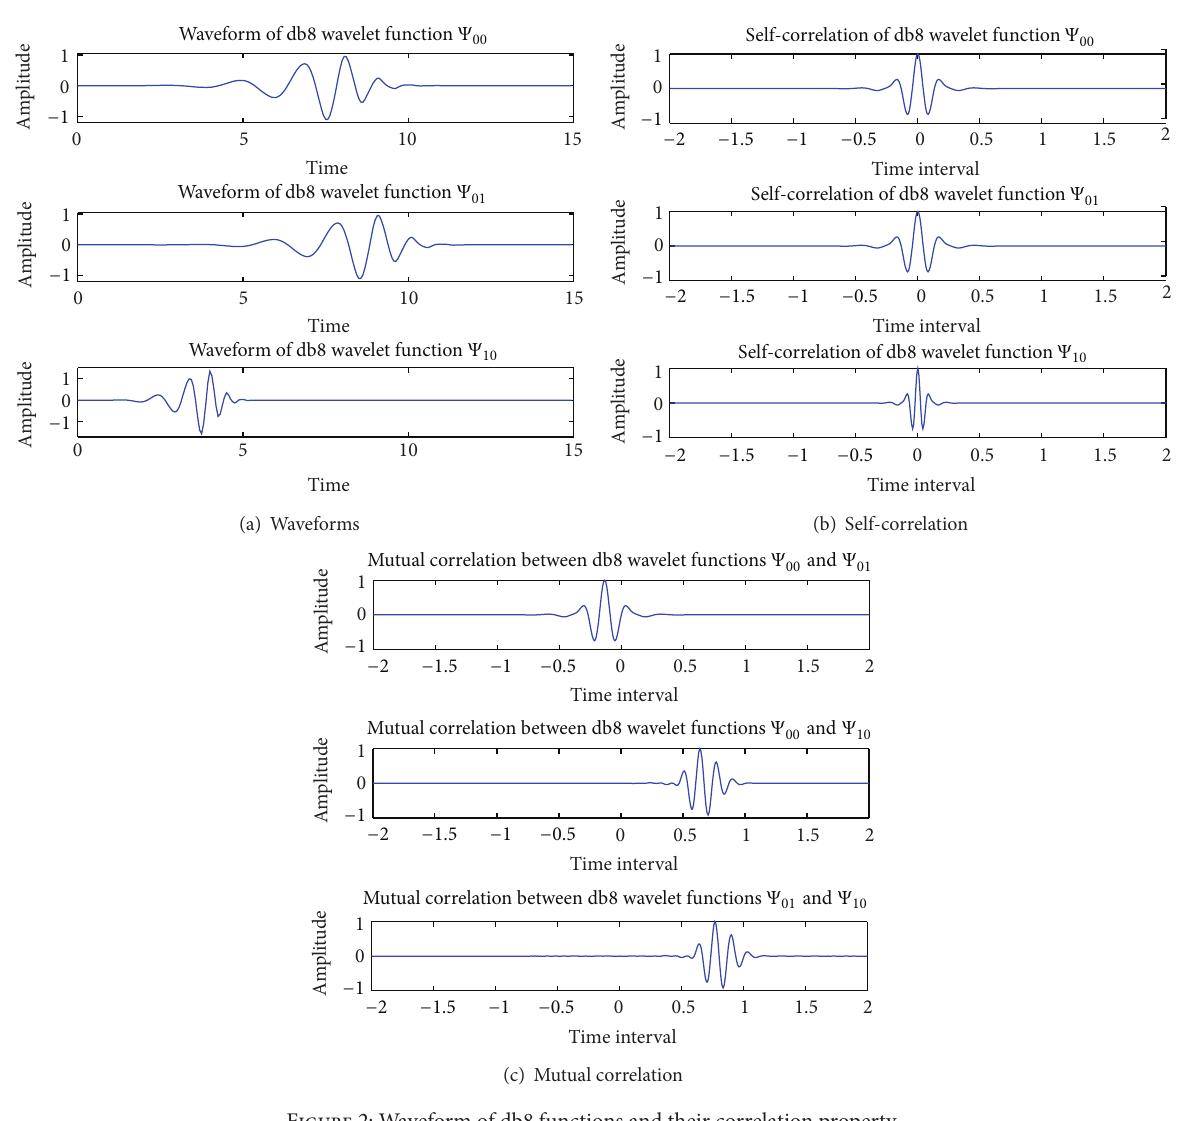
Figure 2: Waveform of db8 functions and their correlation property.